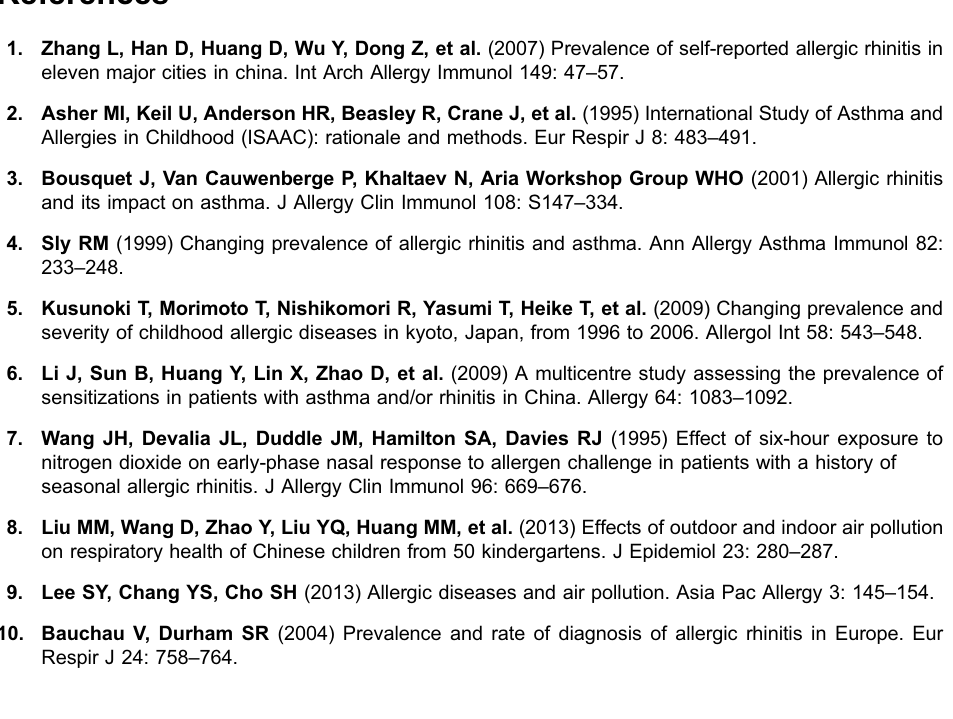
S1 Figure. Proportion of the AR prevalence in the groups of computer usage. The trend of the AR prevalence was analyzed by Chi-Square test. A p -value below 0.05 was considered statistically